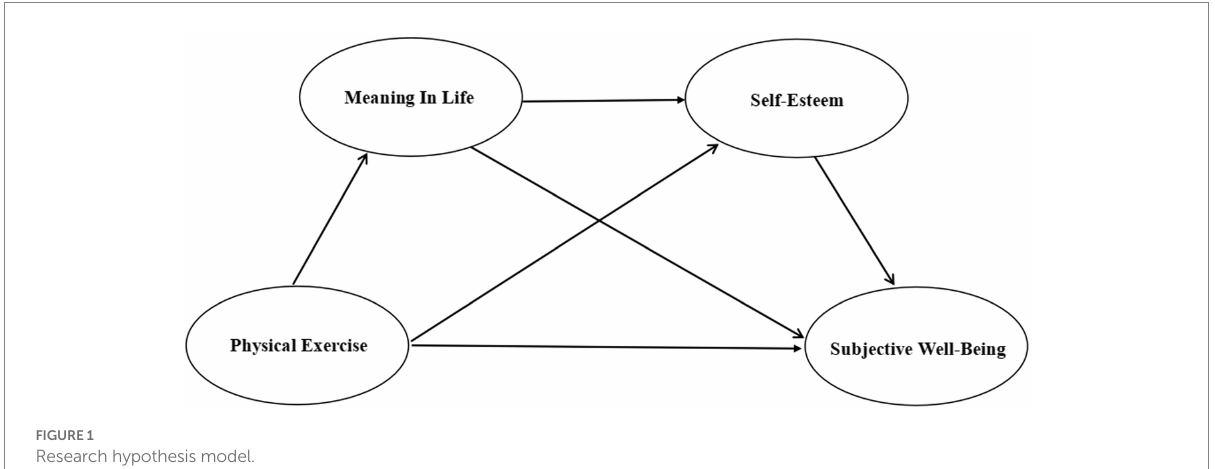
FIGURE 1 Research hypothesis model.